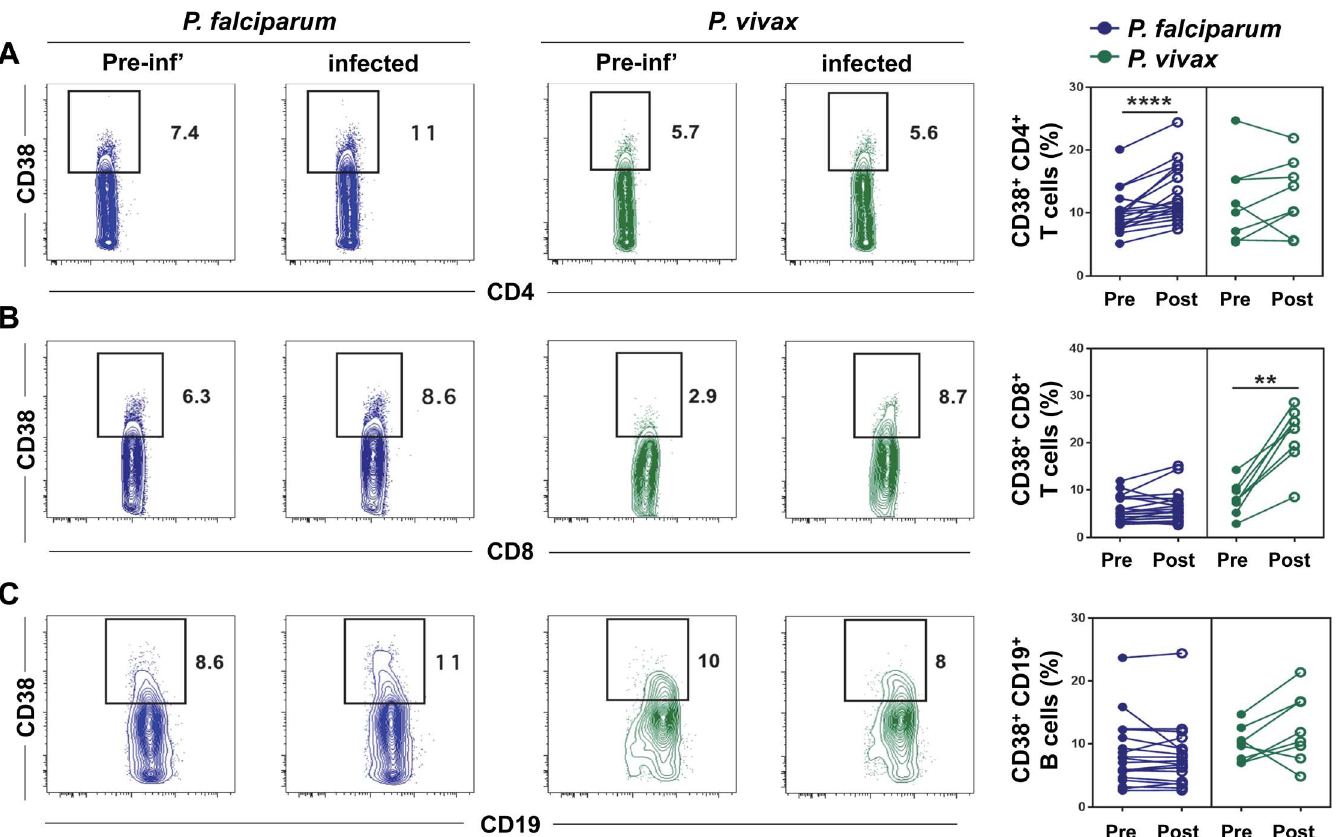
Fig 2. The frequencyof CD38 + T cells and B cells circulating during experimental blood-stage infection with P . falciparum or P . vivax . Blood samples were collected from malaria-naive volunteers prior to (pre) and post-infection (post) with P . falciparum or P . vivax infected erythrocytes, as describedin legendto Fig 1. The frequency of CD38 + cells was determined by flow cytometry in (A) CD4 + T cells, (B) CD8 + T cells, or (C) CD19 + B cells. Differencesin cell frequenciesbetweenpre- and post-infection were determinedusing the non-parametric paired Wilcoxon test. Plots show representative staining of CD38 from one P . falciparum infected volunteerand one P . vivax infected volunteer. Graphs show paireddata from 19 volunteersfrom three independentcohorts ( P . falciparum ) and 8 volunteersfrom four independentcohorts ( P . vivax ); **** , p < 0.0001; ** , p < 0.01.